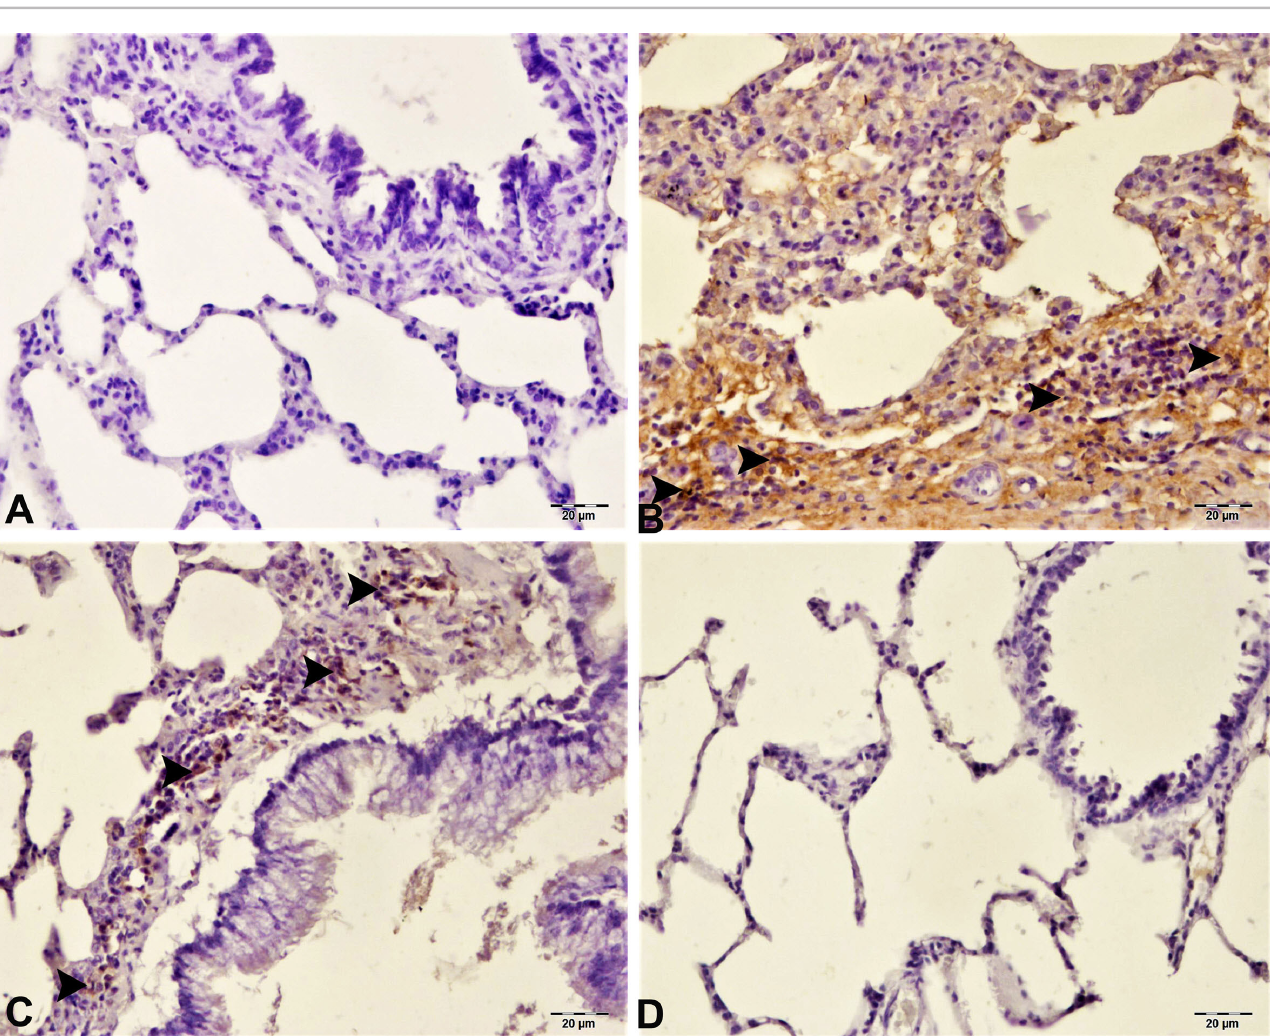
expression observed in areas with peribronchial-peribronchiolar cell infiltration in mononuclear cells (B), BLM+Theo group, intracytoplasmic NF-κB expression observed at mild levels in regions of cell infiltration in mononuclear cells (C), Theo group, negative expression of NF-κB (D), IHC-P, Bar: 20